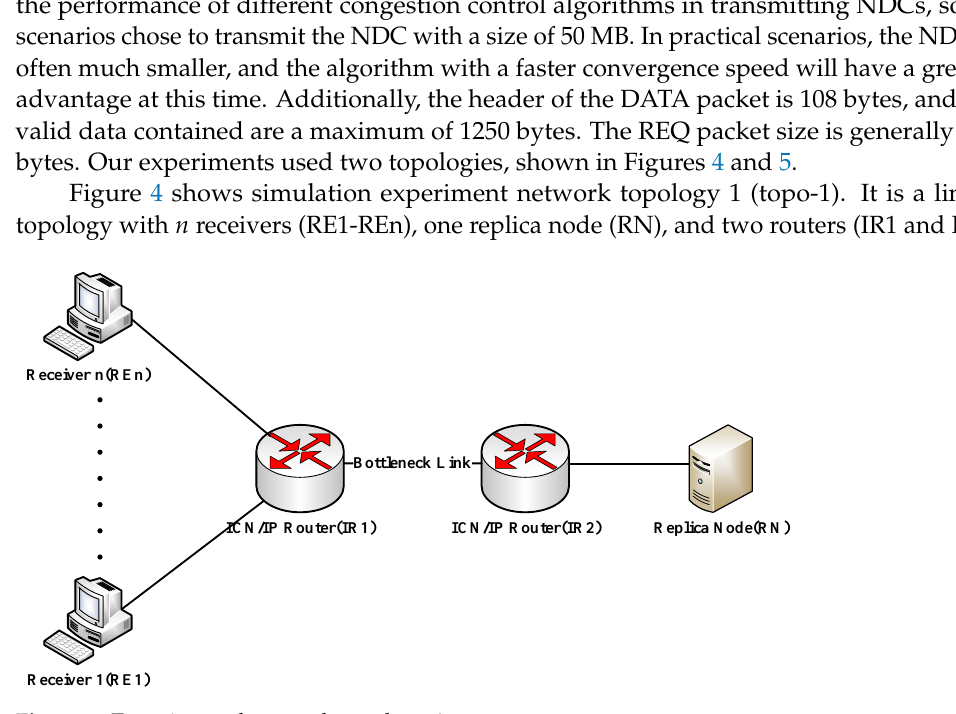
Figure 4. Experimental network topology 1.